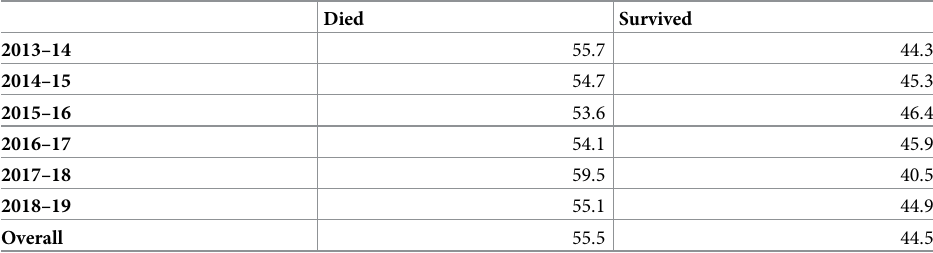
Table 9. Percent of rescues (%) classified as died or survived, based on fate.